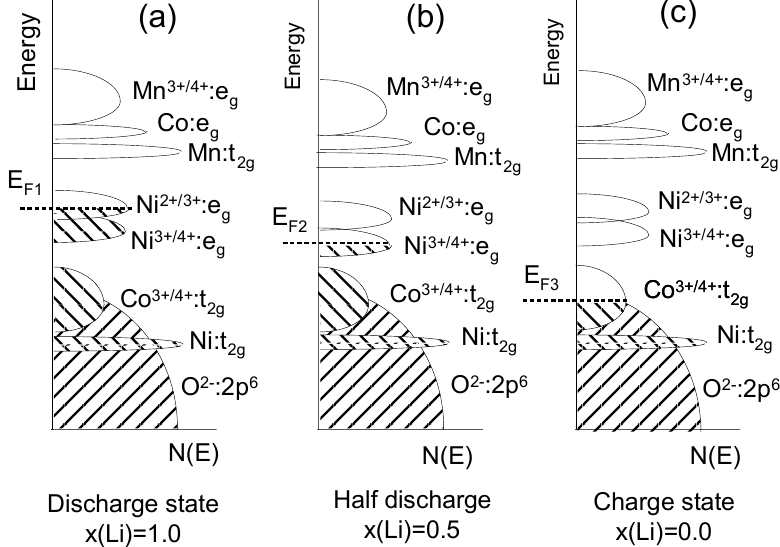
Ni Mn Co O during the charge, for three states x y y 1 − 2 y 2